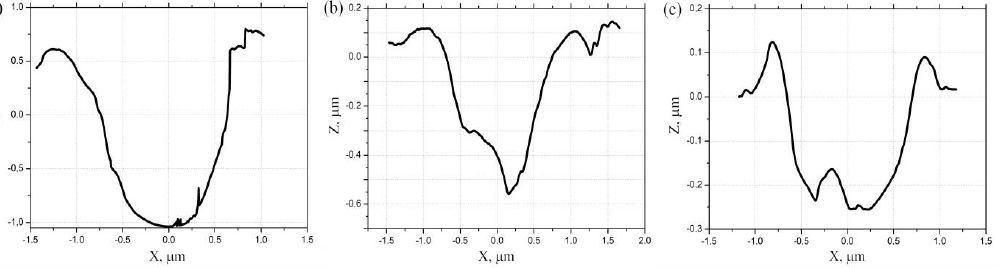
Figure 7. Surface profiles of a single crater inscribed at E = 37.5 nJ and numbers of pulses: 8 ( a ), 3 ( b ), and 1 ( c ).